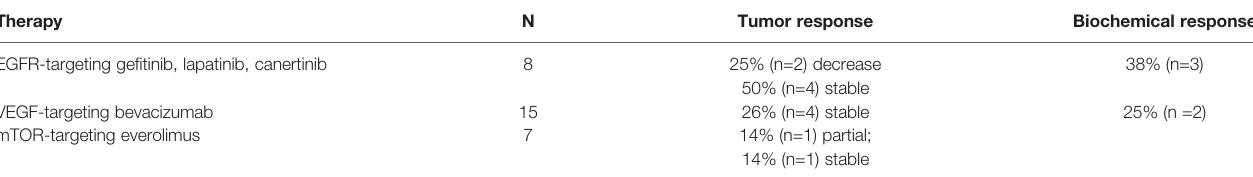
TABLE 3 | Summary of responses to targeted medical therapies. Therapy N Tumor response Biochemical